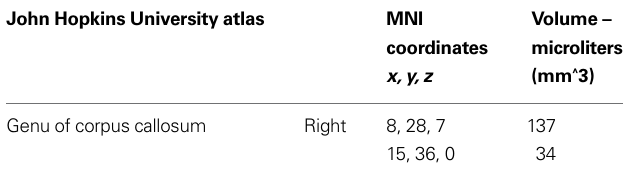
Table 2 | MNI (Montreal Neurological Institute) (Mazziotta et al., 1995) coordinates for regions showing reduced FA values in relatives of schizophrenia patients when compared to controls